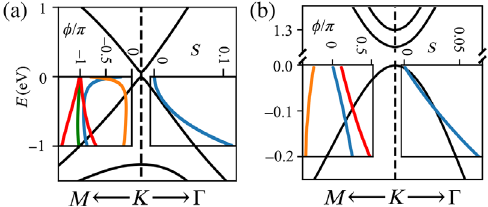
FIG. 1. (a) Characterization of a single valley of noncentro- symmetric graphene on hBN substrate, assuming a translation- invariant, commensurate [64] phase. Left inset: Plot of ϕ (blue), B ˜ λ ≔ ϕ ϕ ϕ (orange), (green), and λ [cf. Eq. (14)] (red) R B þ R (cid:4) against energy. Right inset: Plot of the orbit area ( S ) vs E . (b) Characterization of a single valley of monolayer WSe 2 . Left ϕ ϕ inset: Plot of ϕ (blue), ϕ (orange), and λ ≔ ϕ B R B þ R þ Z (red) vs E . Right inset: Plot of S ð E Þ . (a) and (b) are obtained by ab initio calculations detailed in Appendix